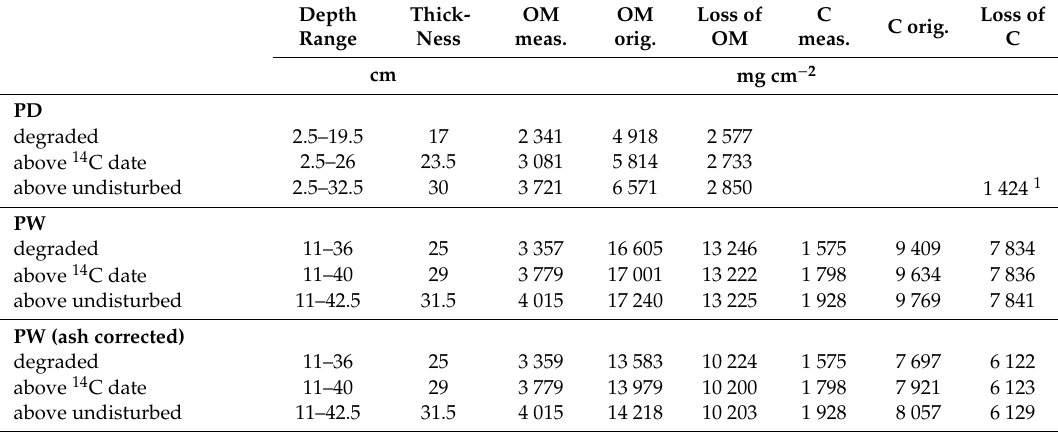
Table 2. Losses of organic matter (OM) at PD and PW and carbon (C) at PW.